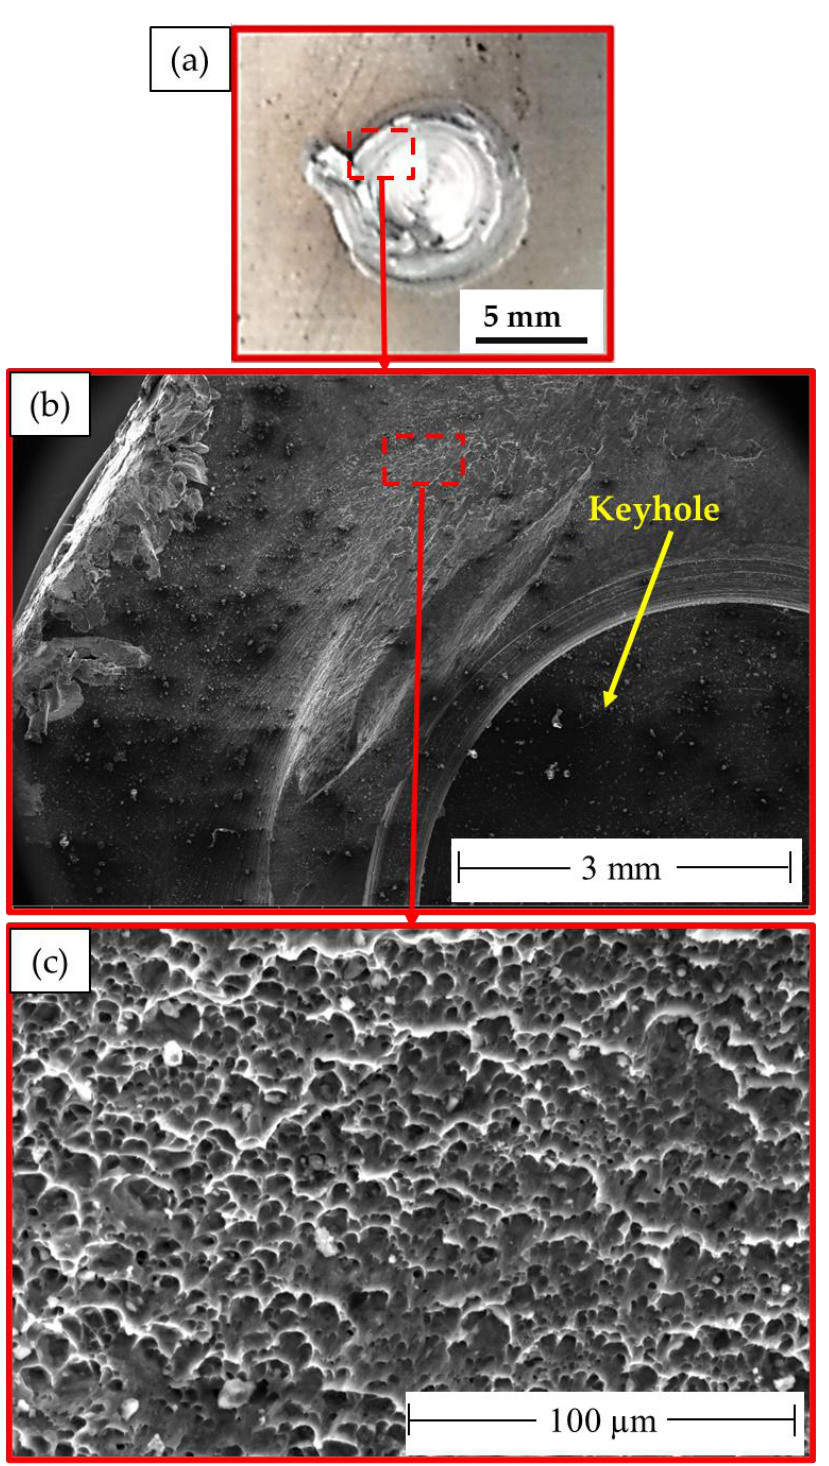
Figure 14. ( a ) Photograph of the top surface of the lower sheet of the joint FSSWed at 500 rpm and 2 s after tension test and ( b , c ) different magnifications of SEM fracture surfaces of the failed joint. Note: dotted red lines enclosed area indicating where the micrographs were taken.